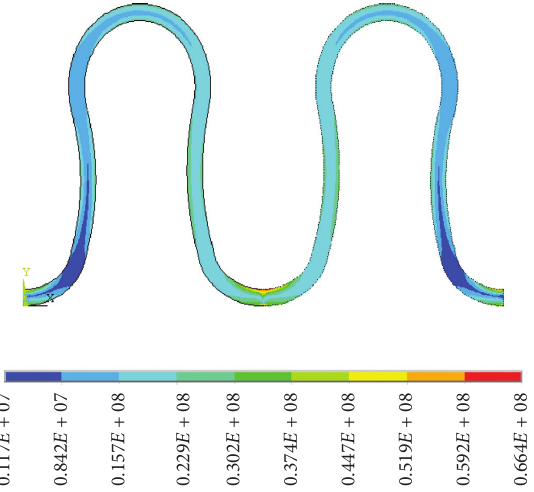
Figure 11: Strain distribution at air inlet and gas outlet side considering thermal stress.